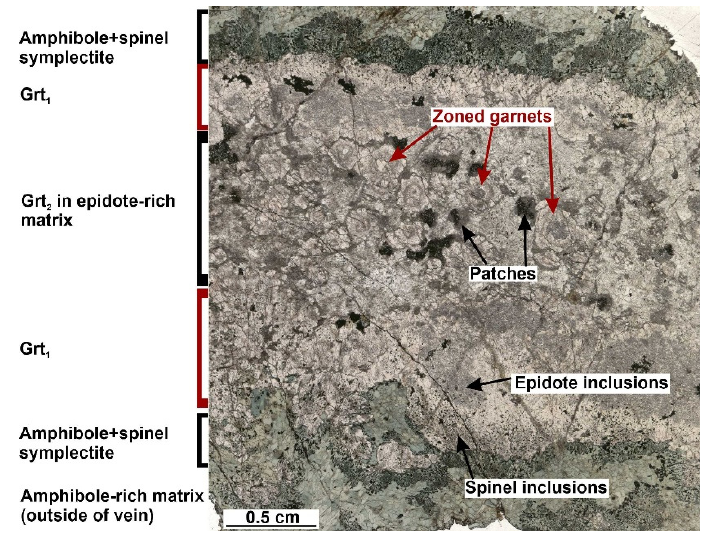
Figure 3. Photo-scan of a thin section of the garnet-rich vein shown in Figure 2d (sample